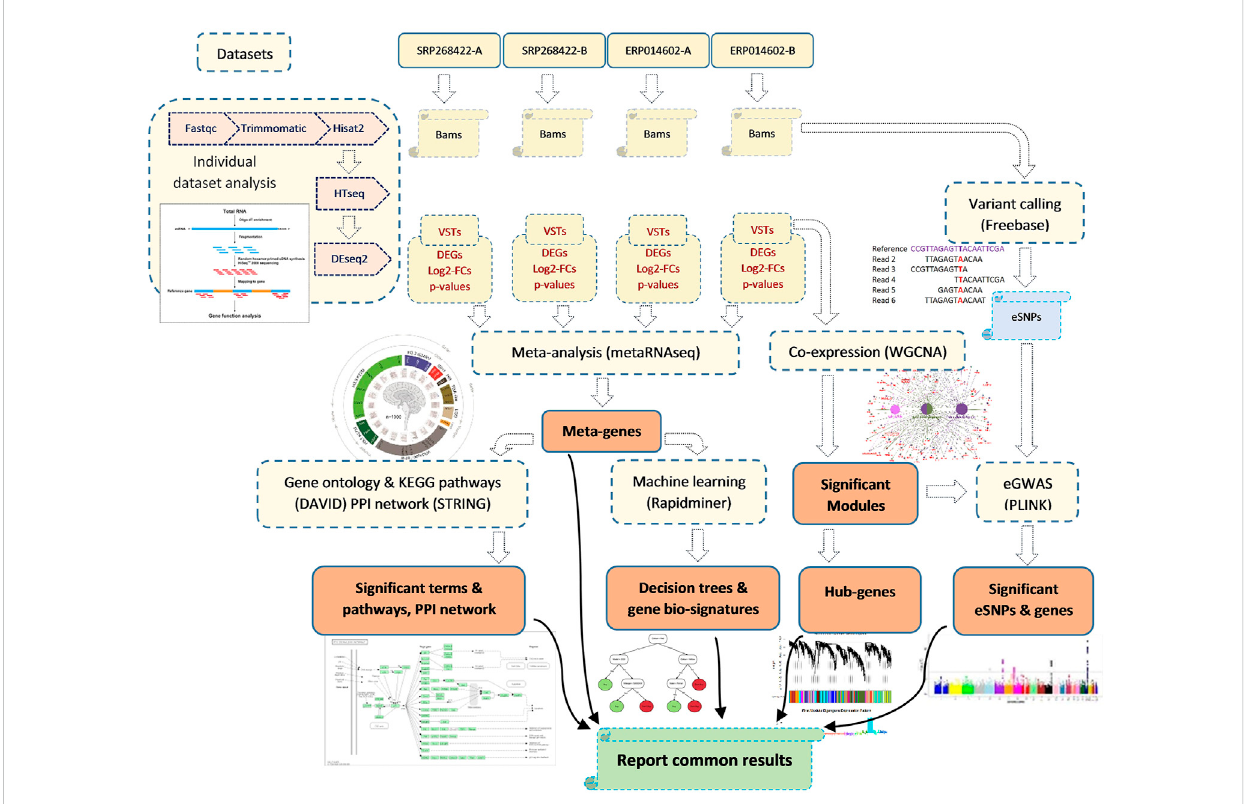
FIGURE 1 Overview of the steps gone for the data collection, preprocessing, analyzing and results combination. The collected datasets belonged to four similarRNA-seqexperimentsthatthemainobjectofallofthemwastoaddresstheeffectofacuteheatstressonchickenlivergeneexpressionpro fi le.The results that obtained commonly from all individual dataset analysis, meta-analysis, weighted gene-co-expression network analysis (WGCNA), machine learning and expression-based genome wide association analysis (eGWAS) were the ultimate base of the identi fi cation of key genes related to the response of chicken to acute heat